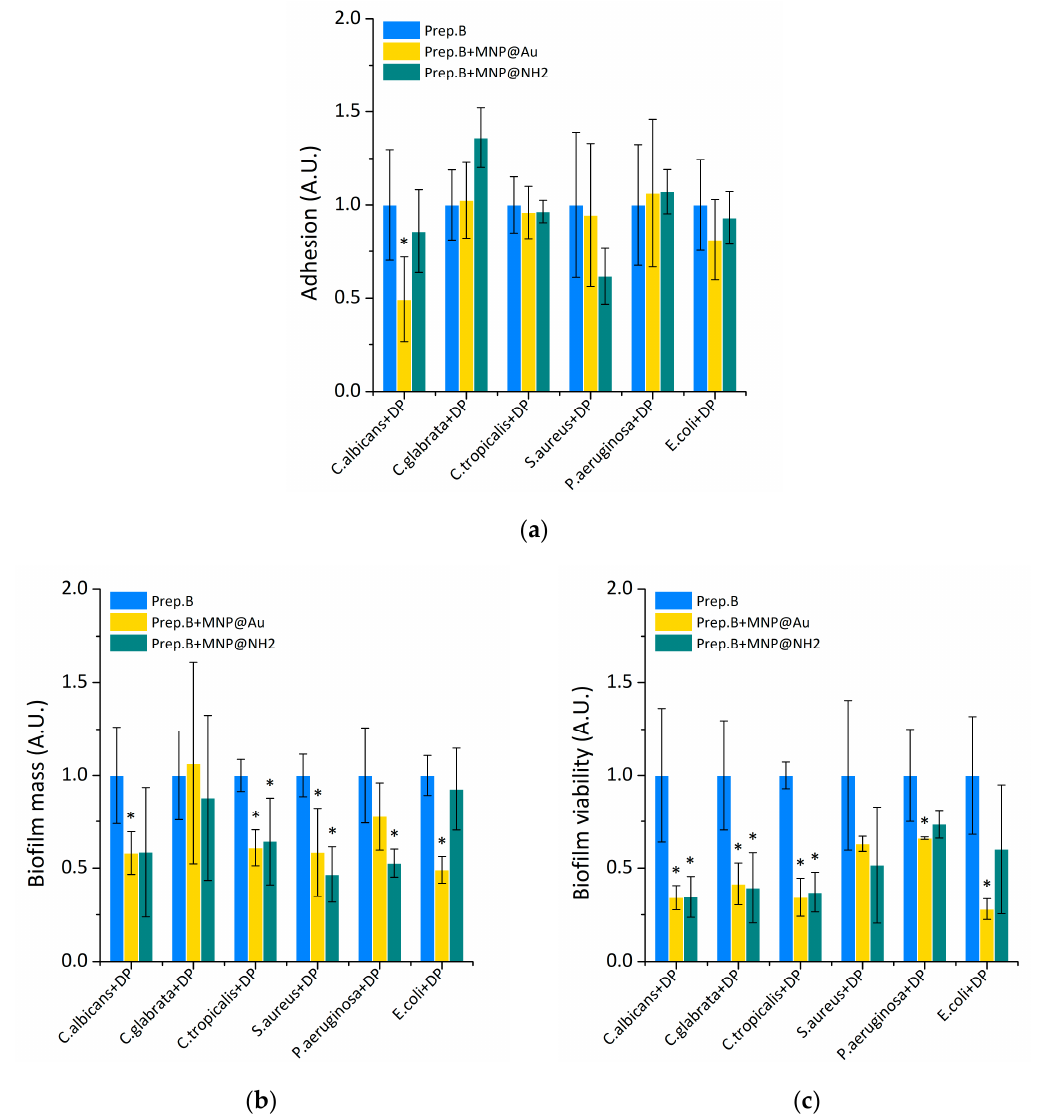
Figure 4. The addition of magnetic nanoparticles to artificial saliva preparations inhibits the growth and biofilm formation of selected oral pathogens in the presence of dental plaque (DP). Panels ( a , b ) show the ability of tested saliva preparations containing magnetic nanoparticles against the microorganism adhesion and the formation of biofilm in the presence of dental plaque. Decreased viability of the cells embedded in the biofilm matrix after treatment with tested saliva formulations containing magnetic nanoparticles in the presence of dental plaque is presented at the panel ( c ). Statistical significance for the tested preparations compared to control was marked by (*) p ≤ 0.05. Results from 3 measurements ±SD.